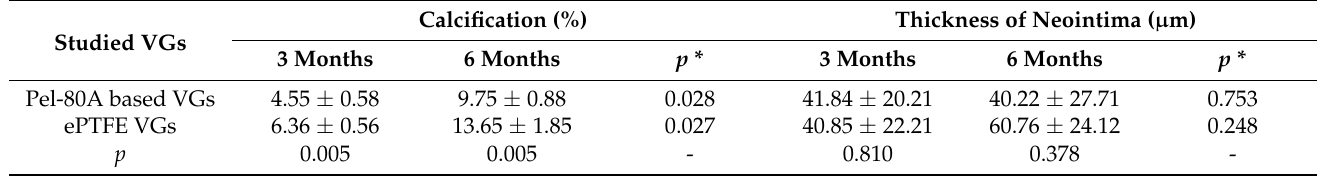
Table 4. The calcification and the thickness of the neointima in studied VGs at different observation time points. Calcification (%) Thickness of Neointima ( µ m) Studied VGs 3 Months 6 Months p * p * Pel-80A based VGs ePTFE